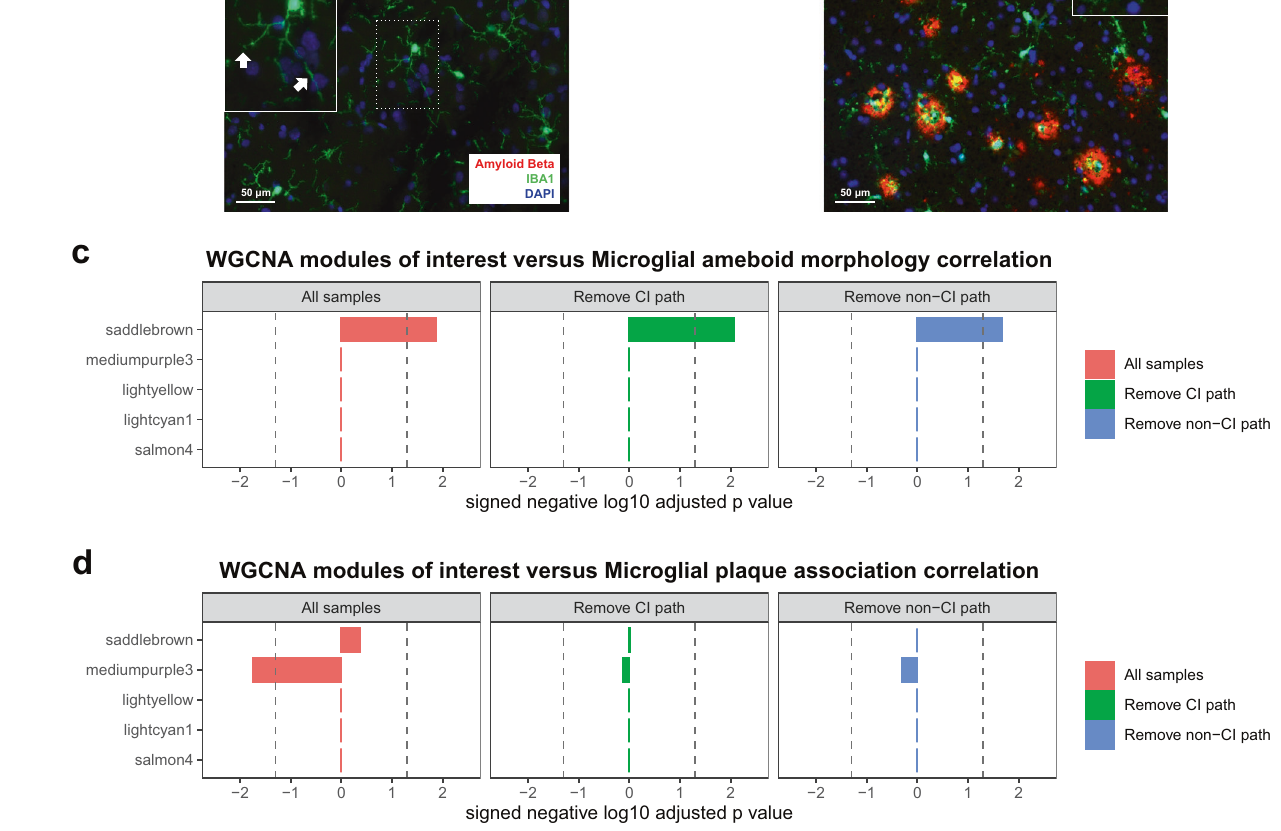
Fig. 8 Our microglial modules correlate with microglial morphology and location. We performed β -amyloid/IBA-1 dual staining on selected cases from our cohort. a Cases without β -amyloid showed microglia with longer processes (white arrow; microglial cell in inset is blow-up from area demarcated with dotted line), while b cases with β -amyloid pathology tended to show more ameboid, activated microglia. We stained 59 biopsies for β -amyloid/IBA-1 and this data is used to calculate correlations in c , d . As noted in the “ Results ” section, microglial ameboid morphology moderately correlated with plaque area in the same biopsy ( r = 0.3; two-sided p value = 0.01; ameboid morphology was measured using the compactness metric in Cellpro fi ler — see “ Methods ” for details). c , d We assessed the Spearman ’ s correlation with two-sided signi fi cance of the top fi ve microglial modules shown in Fig. 5e – i for microglial ameboid morphology (measured using the compactness metric in Cellpro fi ler — see “ Methods ” for details) ( c ) and microglial β -amyloid plaque association ( d ). Only saddlebrown signi fi cantly correlates with microglial ameboid morphology, and this is seen whether or not samples with AD pathology come from patients who report cognitive symptoms (the green and blue bars represent groups formed using the same methodology as in Fig. 3a, b). In addition, only the mediumpurple3 module signi fi cantly (and negatively) correlates with microglial plaque association, suggesting that plaque association correlates with loss of homeostatic genes. When we eliminate samples with AD pathology based on cognitive status, we lose signi fi cance for mediumpurple3 , which suggests that this correlation is somewhat weak in this dataset, and also that both sample groups are likely contributing to the overall signi fi cance of this fi nding in the full dataset. In c , n = 59 for all samples (red bars), n = 35 in the Remove CI path group (green bars), and n = 42 in the Remove non-CI path group (blue bars); in d , n = 29 for all samples, 11 in the Remove CI path group (green bars), and n = 18 in the Remove non-CI path group (blue bars). The three panels in c and the three panels in d are each separately Bonferroni adjusted — dotted line in all panels is p value = 0.05; see Supplementary Data 12 for all Spearman ’ s correlations, p values, and adjusted p values from this fi